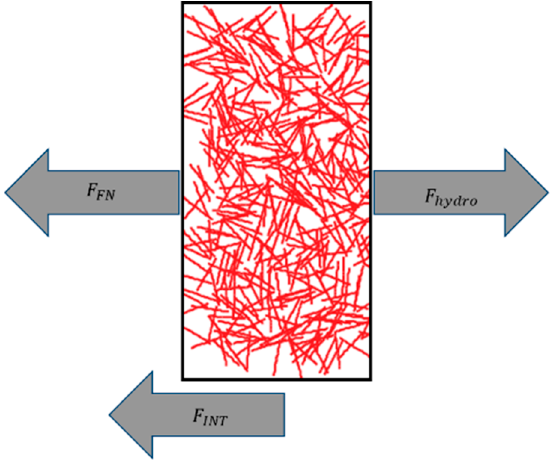
Figure 6. Fiber phase force balance.